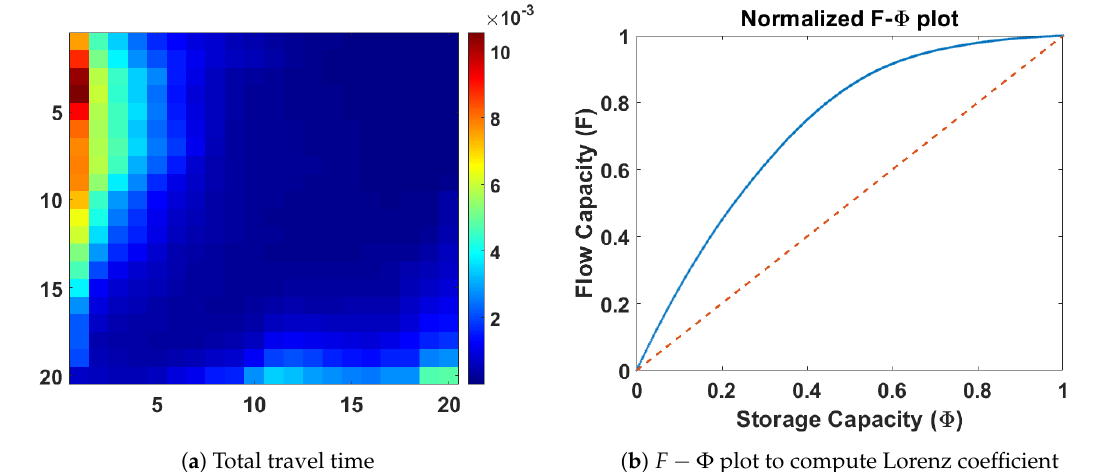
Figure 3. ( a ) The total travel time of the particle injected at injector to any point in the reservoir ( b ) F − Φ plot to compute Lorenz coefficient as the area under the solid F − Φ curve and the dashed line F = Φ .